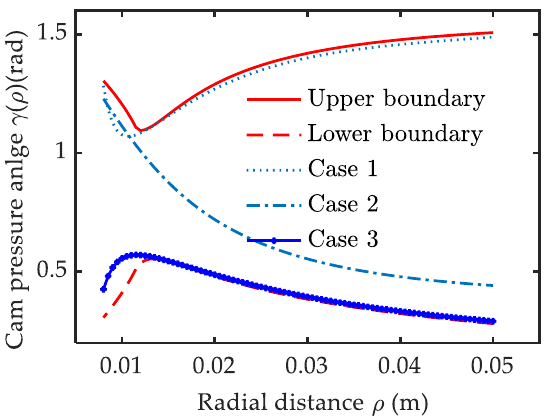
Figure 6. Pressure angle synthetic based on different cases.